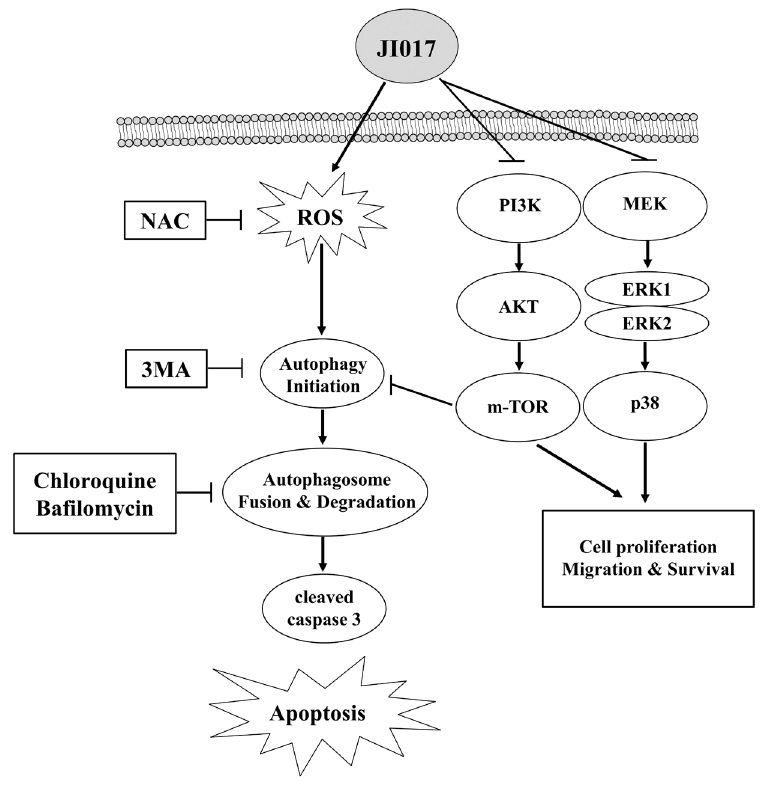
Figure 6. Mechanistic pathway diagram for the autophagy activation potency of JI017 through AKT, ERK inhibition , and ROS induction in lung cancer .